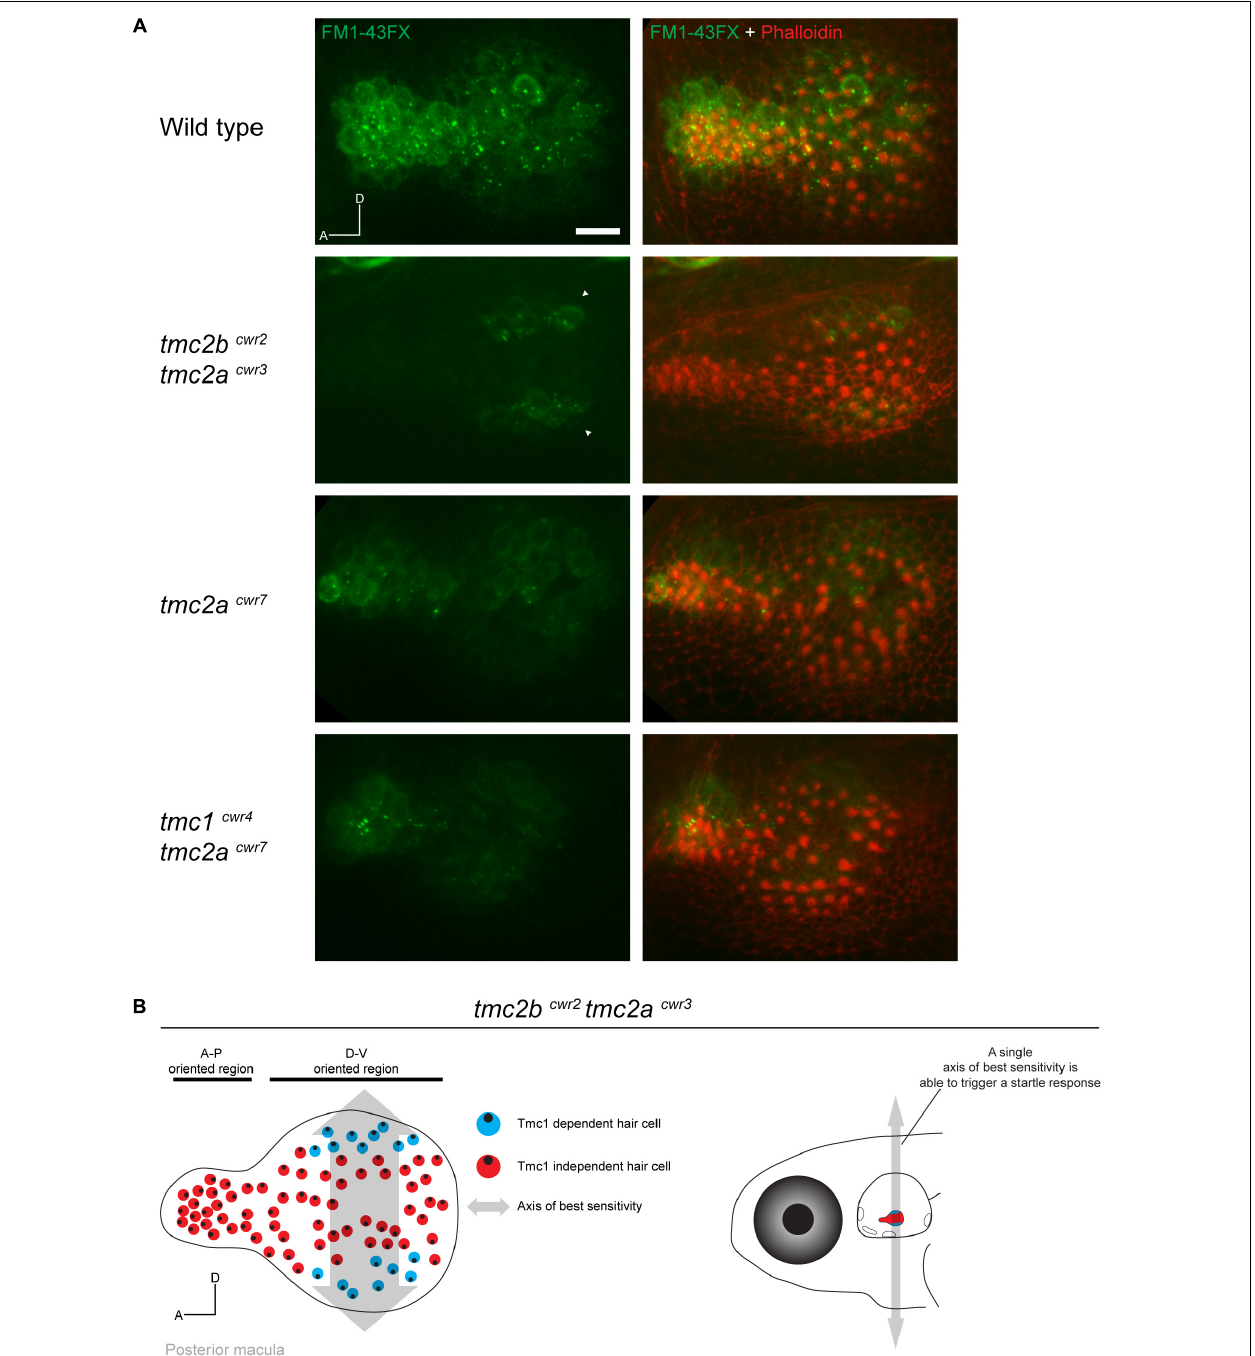
FIGURE 4 | Hair cells of the posterior macula are differentially dependent on Tmc proteins. (A) Representative images of FM1-43FX (green) uptake in posterior maculae of wild-type and mutant larvae at 7 dpf. Hair bundles are labeled with phalloidin (red). In a wild-type macula, passage of FM1-43FX is observed in all hair cells. In the tmc2b cwr2 tmc2a cwr3 double mutant, FM1-43FX uptake is limited to two symmetrical stripes of hair cells located toward the posterior of the macula at the dorsal and ventral poles (arrowheads). In contrast, the tmc2a cwr7 single mutant or tmc1 cwr4 tmc2a cwr7 double mutant hair cells do not reveal a pattern similar to the tmc2b cwr2 tmc2a cwr3 double mutant. A, anterior; D, dorsal. Scale bar = 10 µ m. Similar patterns of saccular uptake were observed for five larvae for each mutant type and control. (B) (Left) Map of hair cell positions and hair bundle polarities in relation to Tmc1 use within the posterior macula based on the tmc2b cwr2 tmc2a cwr3 double mutant. Each color circle (red or blue) represents an individual hair cell, and the black dot within represents the position of the kinocilium, which reflects bundle polarity. Double-headed arrow indicates axis of best sensitivity preserved in the tmc2b cwr2 tmc2a cwr3 double mutant. (Right) Schematized zebrafish head depicting just one axis of best sensitivity (dorsal-ventral) able to elicit a startle response.